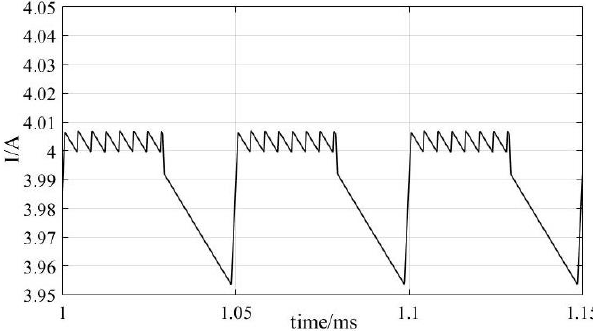
Figure 10. Current control loop with a half-bridge SPA.